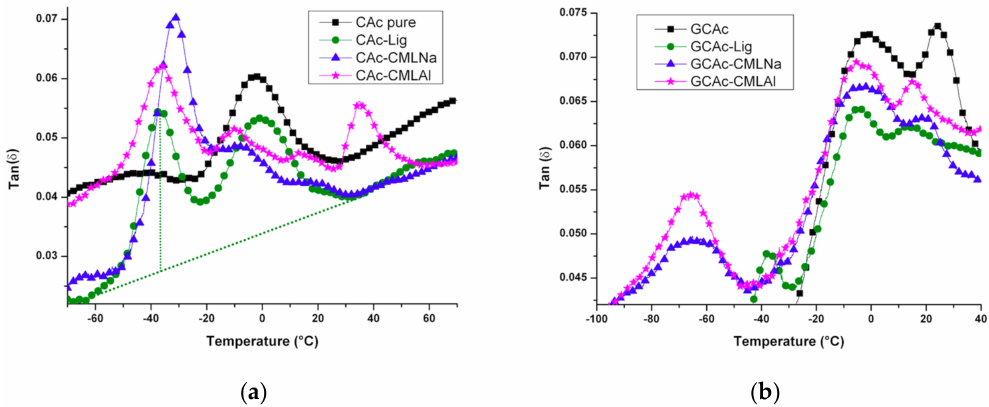
Figure 8. Tan δ versus temperature for the membranes of groups I ( a ) and II ( b ).